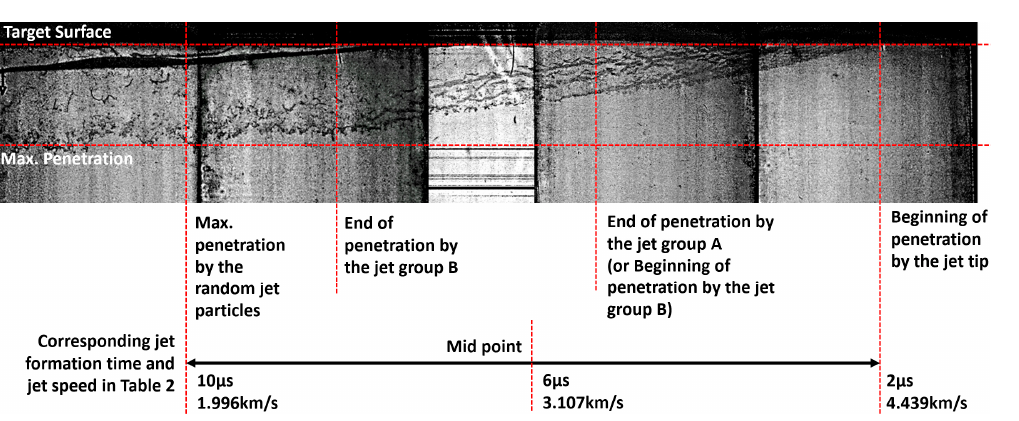
Figure 9. Connected X-ray images and corresponding jet properties at the liner collapse point.